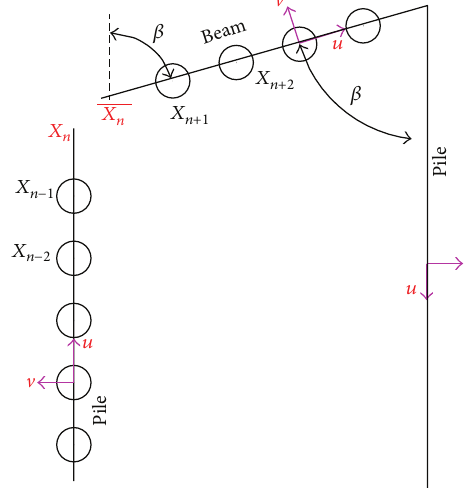
Figure 3: Scheme of local coordinate system transformation between pile and connection